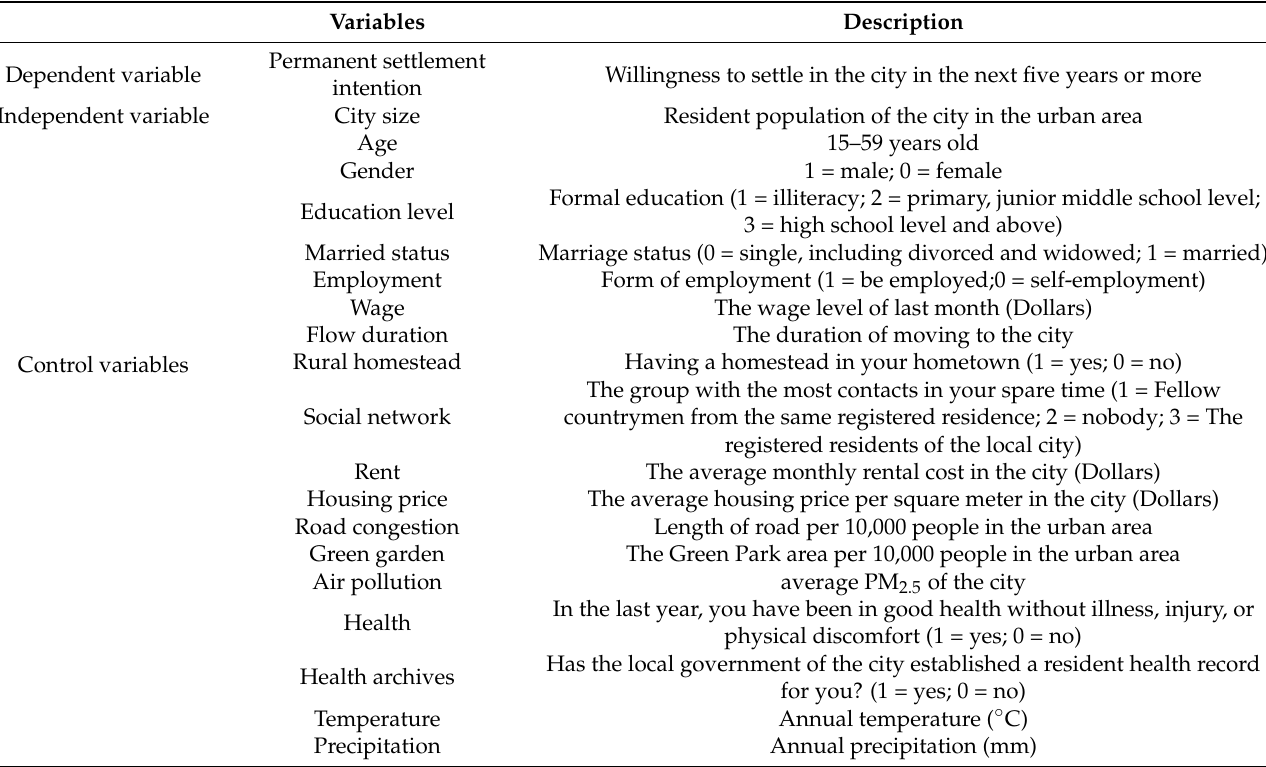
Table 1. The summary of variable